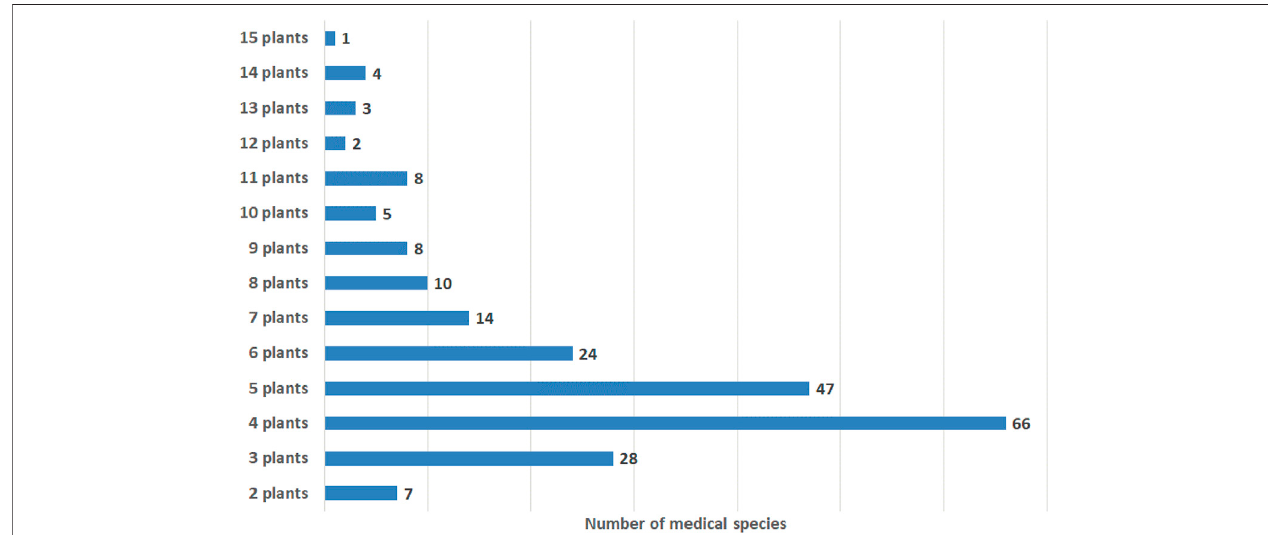
FIGURE 1 | Number of medical species according to the number of plants in the formulation.